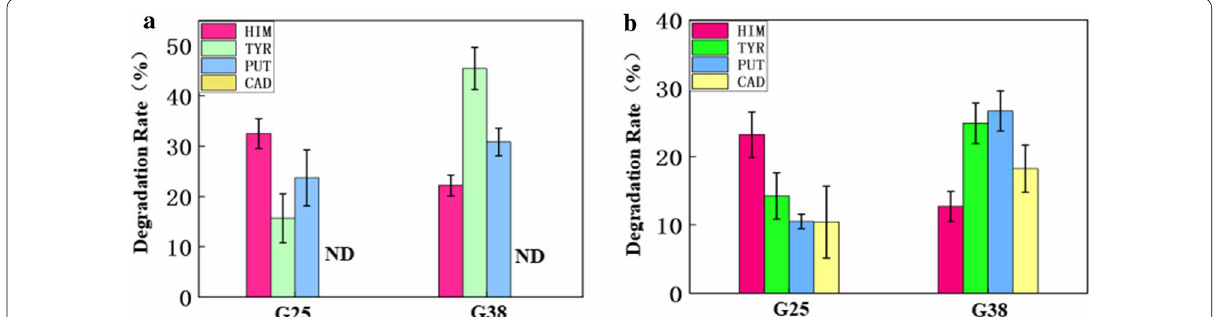
Fig. 6 Degradation of BAs in other fermentation products by strains, data are the means Degradation of BAs in cheese by strains. b Degradation of BAs in natto by